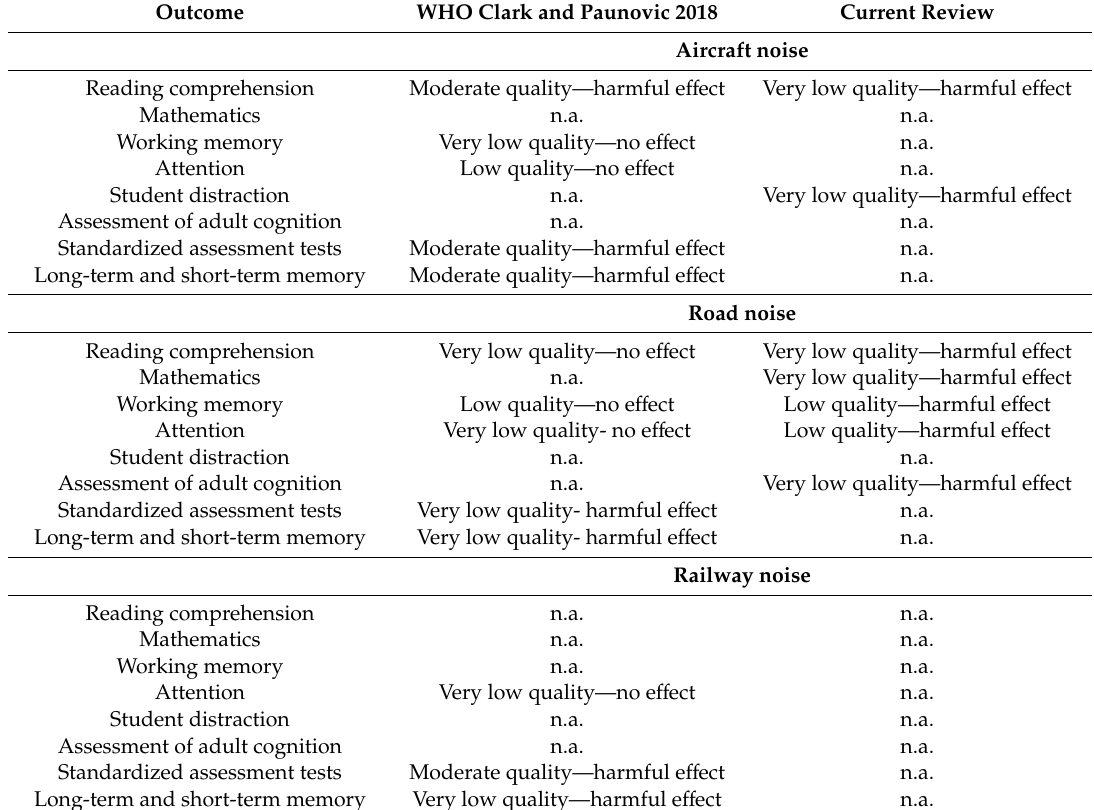
Table 14. Comparison of the strength of the evidence for the WHO 2018 and the current review for aircraft, road, and railway noise and